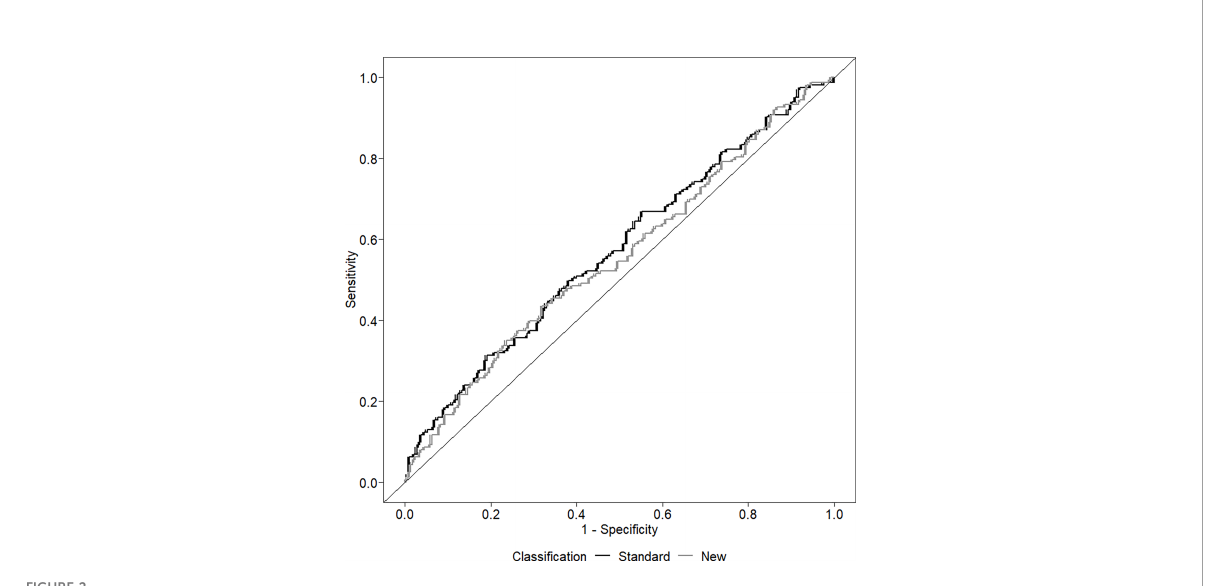
FIGURE 2 Receiver operating curve (ROC) investigating the ability of the two classi fi cations to discriminate among the presence/absence of left ventricular